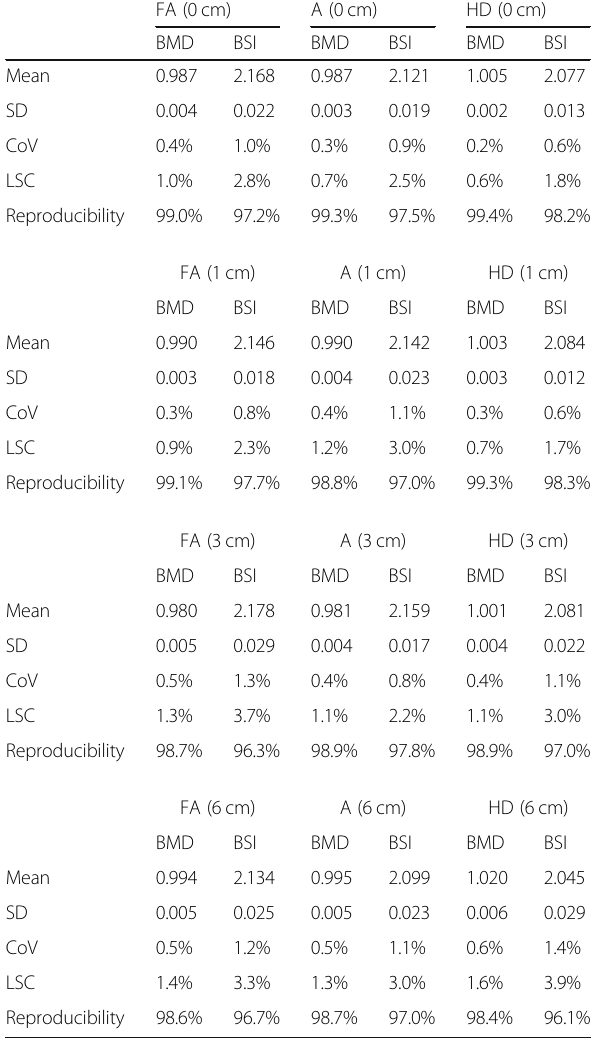
Table 1 BMD and BSI mean values and their SD, LSC%, and reproducibility. Data are presented according to the specific scan mode and to the degree of soft tissue